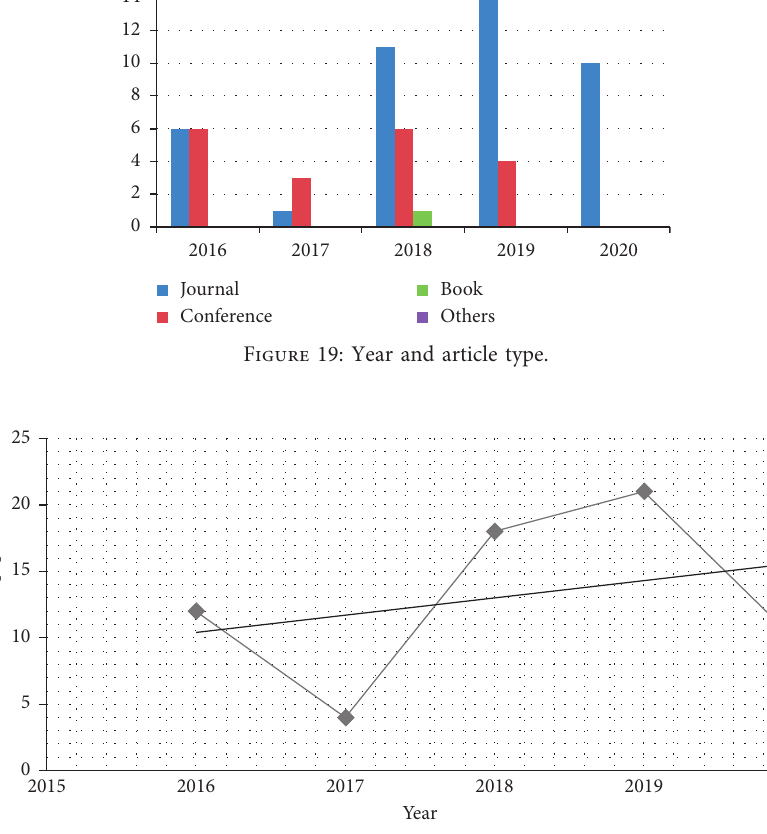
Figure 20: Number of papers in the given